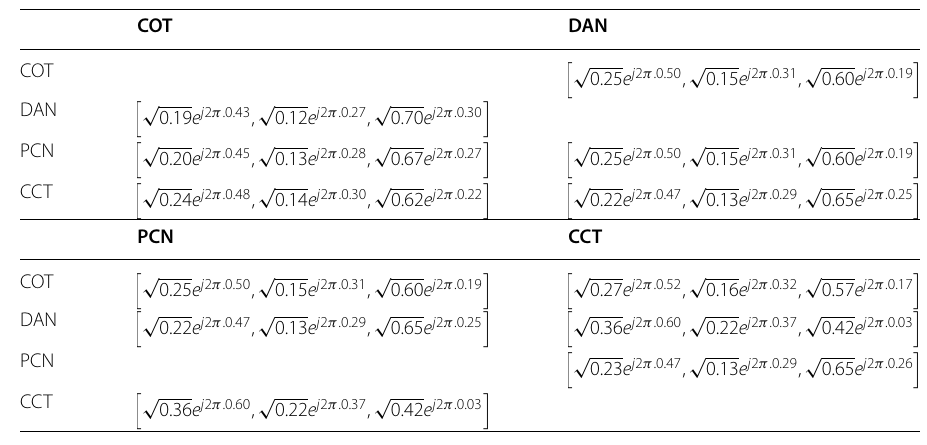
Table 4 Average values of quantum spherical fuzzy numbers for the